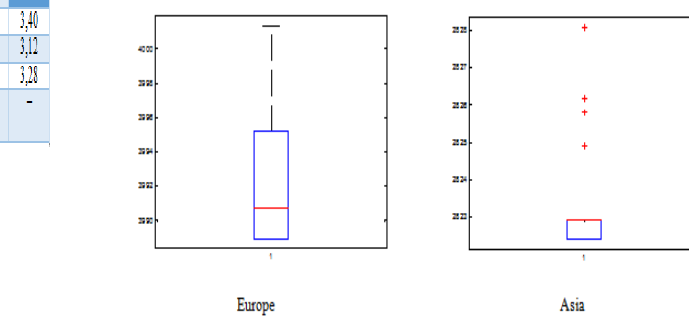
Figure 6: Box graphics of GA solutions of the